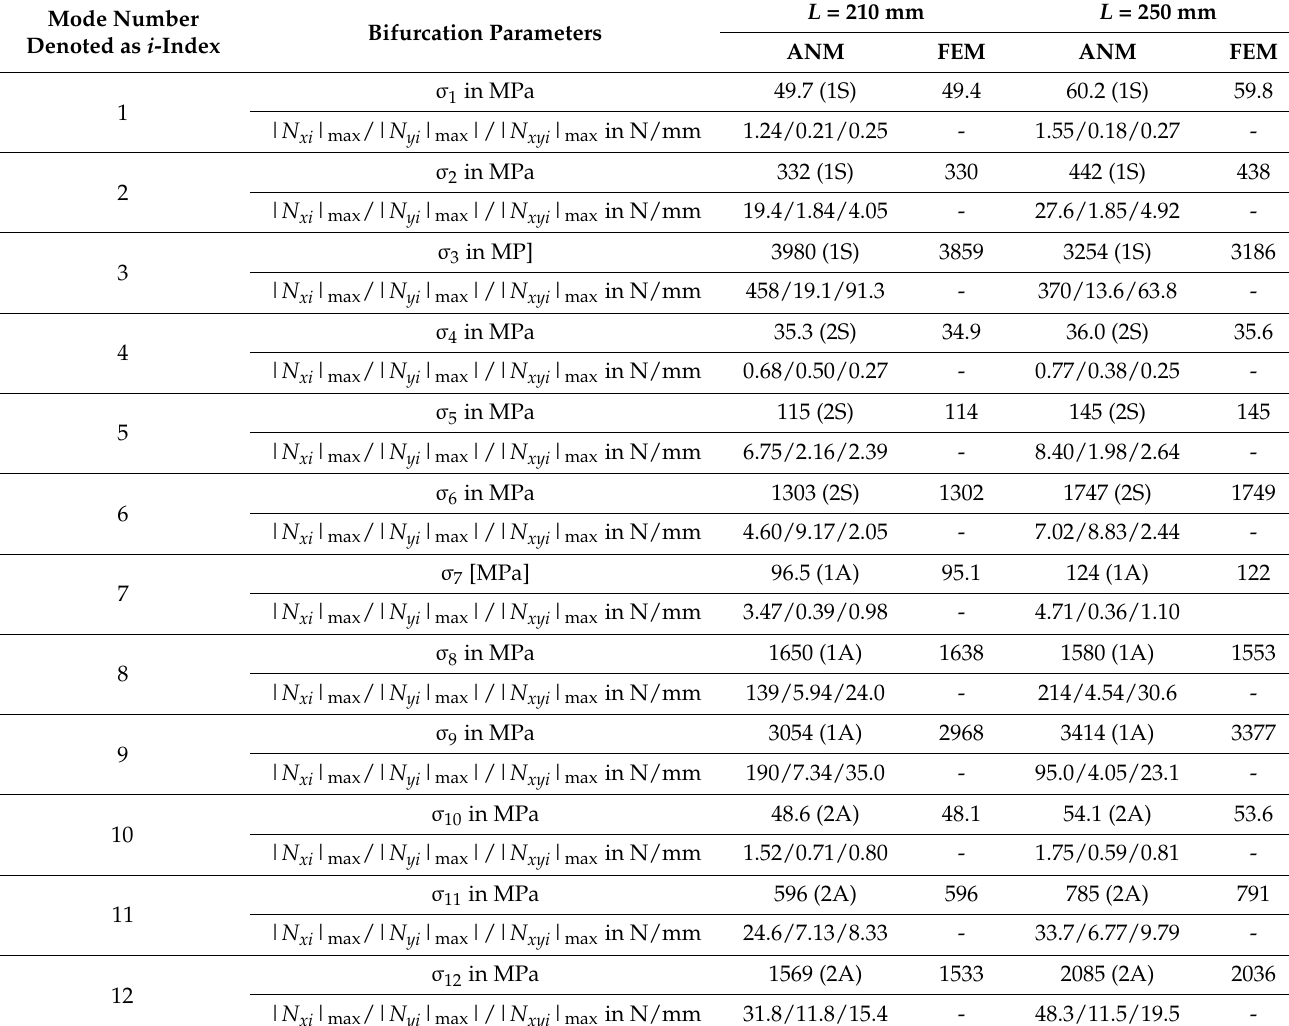
Table 1. Bifurcationalstresses(i.e., σ i inMPa)andmaximalabsolutevaluesofmembraneforces(i.e.,| N xi | max /| N yi | max |/| N xyi | max in N/mm) for selected buckling modes of channels with two lengths: L = 210 mm and L = 250